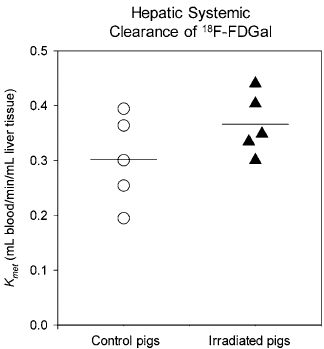
Figure 3. Individual clearance values of [ 18 F]FDGal PET in control pigs and irradiated pigs. Control pigs are shown as white circles and radiation pigs as black triangles. Horizontal bars represent groups